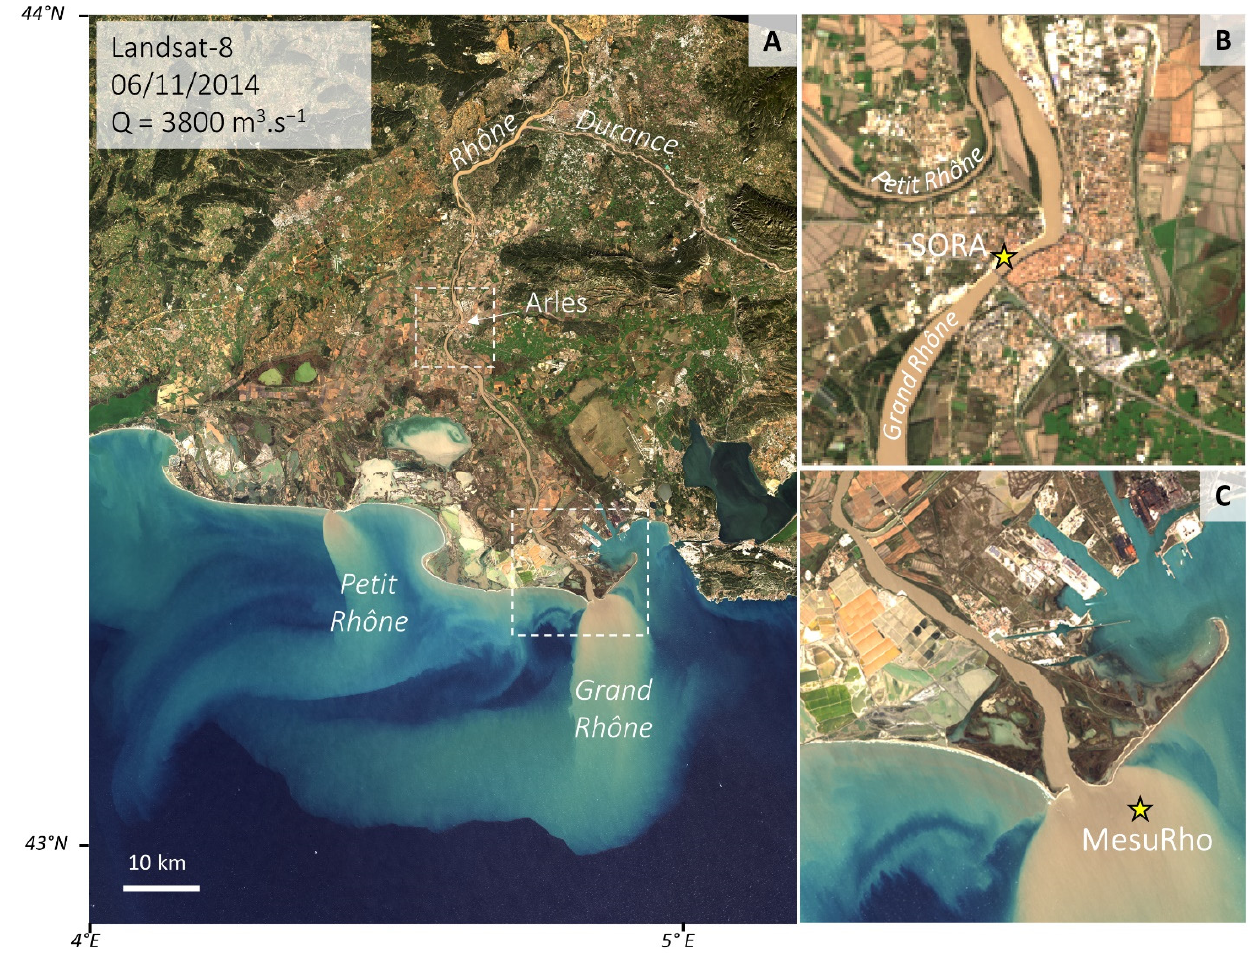
Figure 1. ( A ) Study area (Landsat8-OLI image, 6 November 2014). The Rhône River crosses the city of Arles and reaches the sea at about 45 km kilometers southward, forming a well-defined river plume. ( B ) The SORA station (yellow star) where the SPM concentration and associated river discharge are measured is located in the city of Arles. ( C ) The MesuRho platform is located 2 km from the river mouth, which is inside the river plume except under very strong southeastern wind conditions or very low SPM concentration periods.